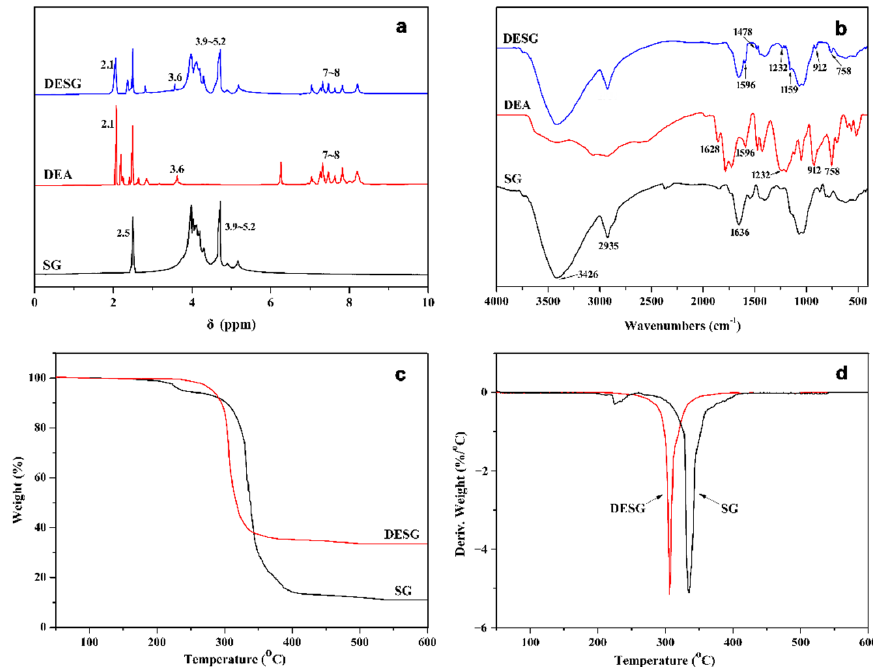
Figure 1. A DESG preparation route.